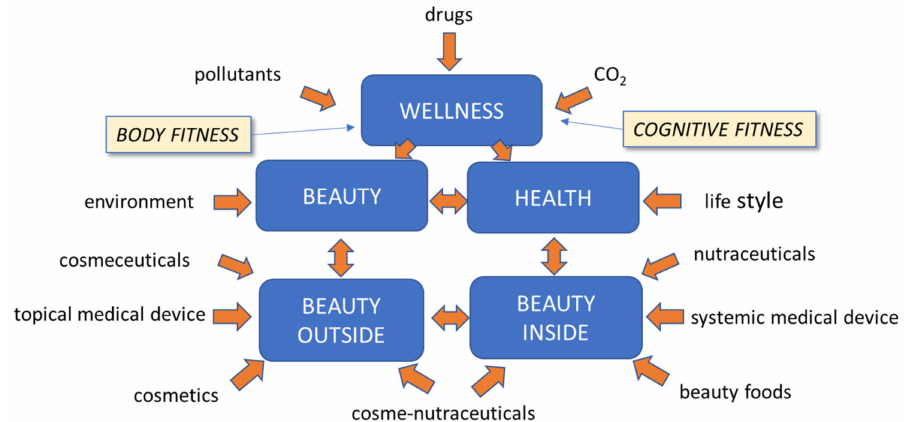
Figure 1. Total beauty and health effect from outside and